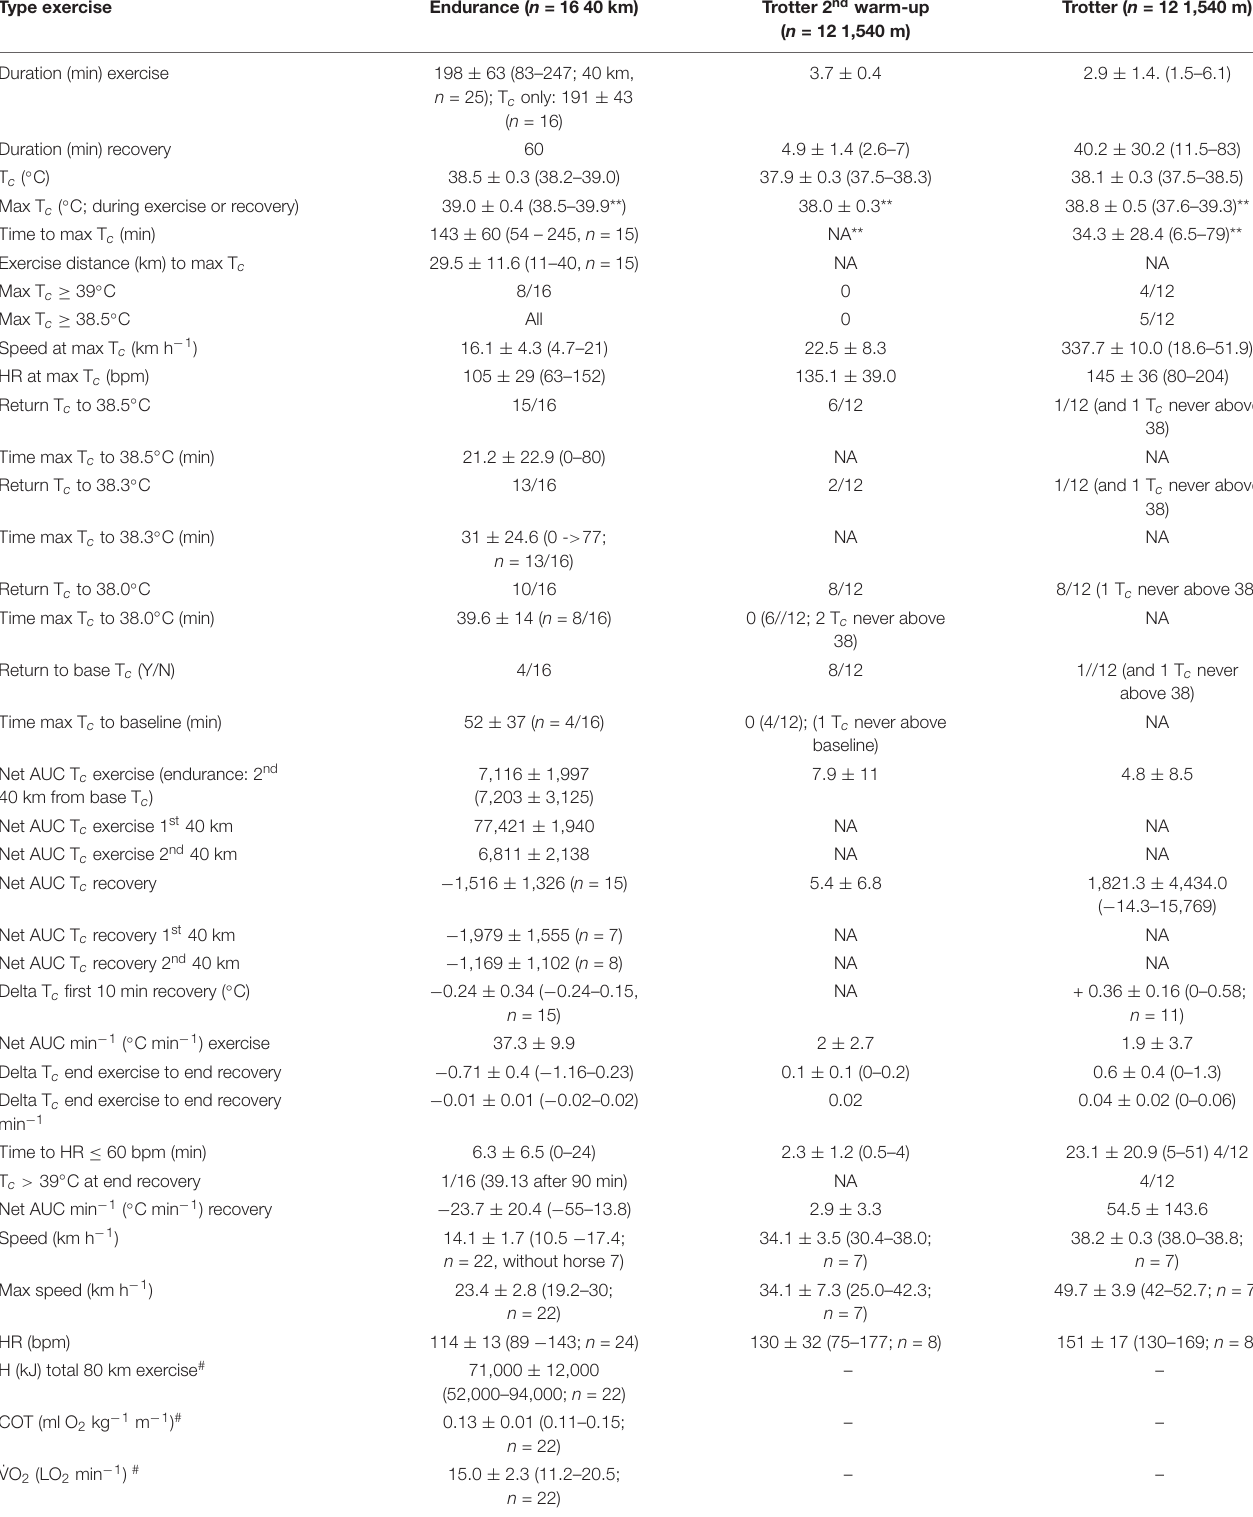
TABLE 2 | Overall variables during exercise and recovery of endurance and trotter